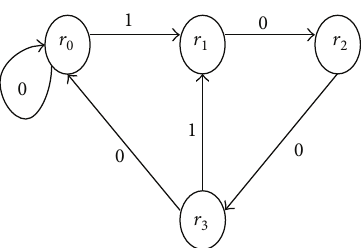
Figure 1: The corresponding graph 𝐺 24 of the matrix 𝐵 24